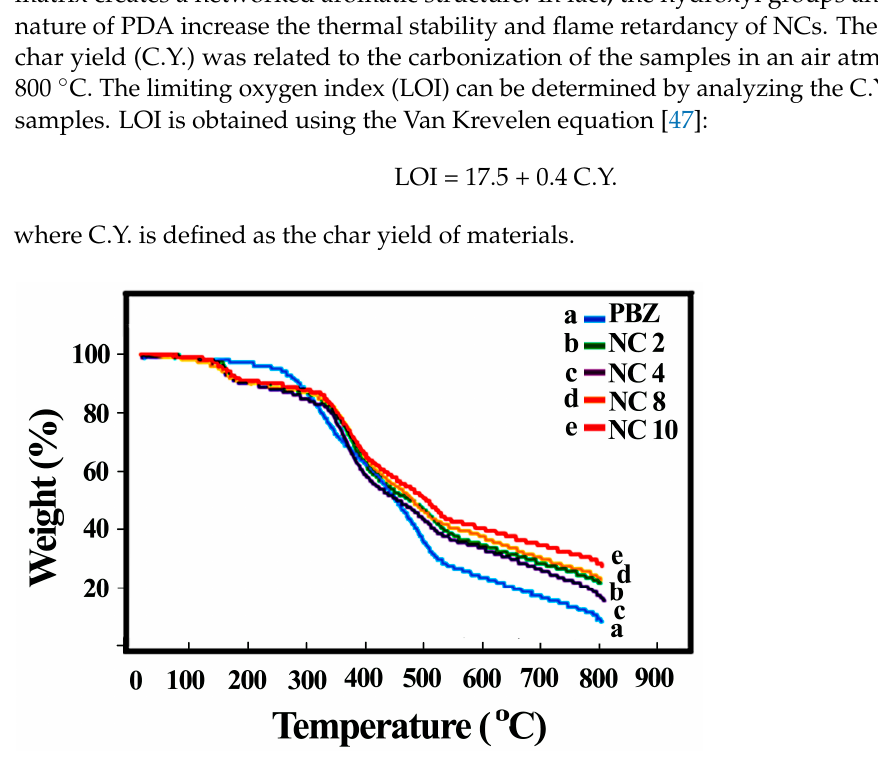
Figure 14. TGA thermograms of NCs. Table 1. Thermal properties of the PBZ, and PBZ/CeO 2 NCs.